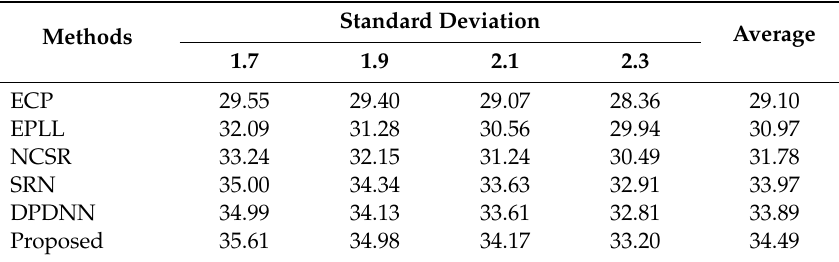
Table 3. The PSNR results of deblurred images for all evaluated methods.